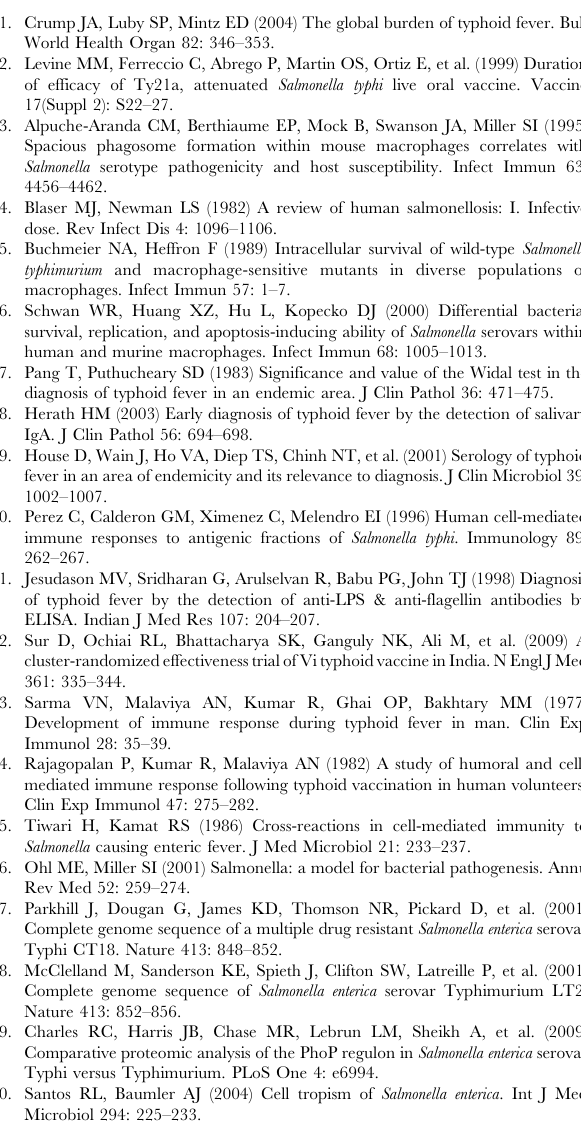
Table S1 Mass spectrometric analysis of S . Typhi membrane